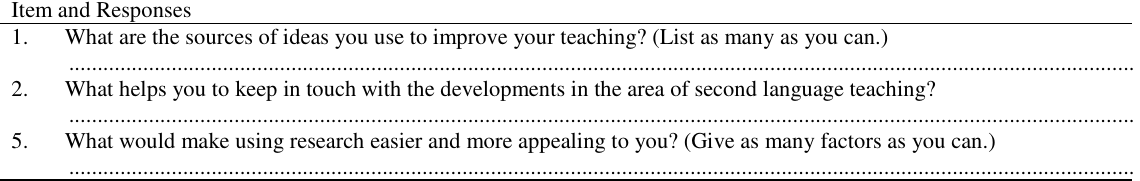
Table 1a Open-ended items on the theme access to research Item and